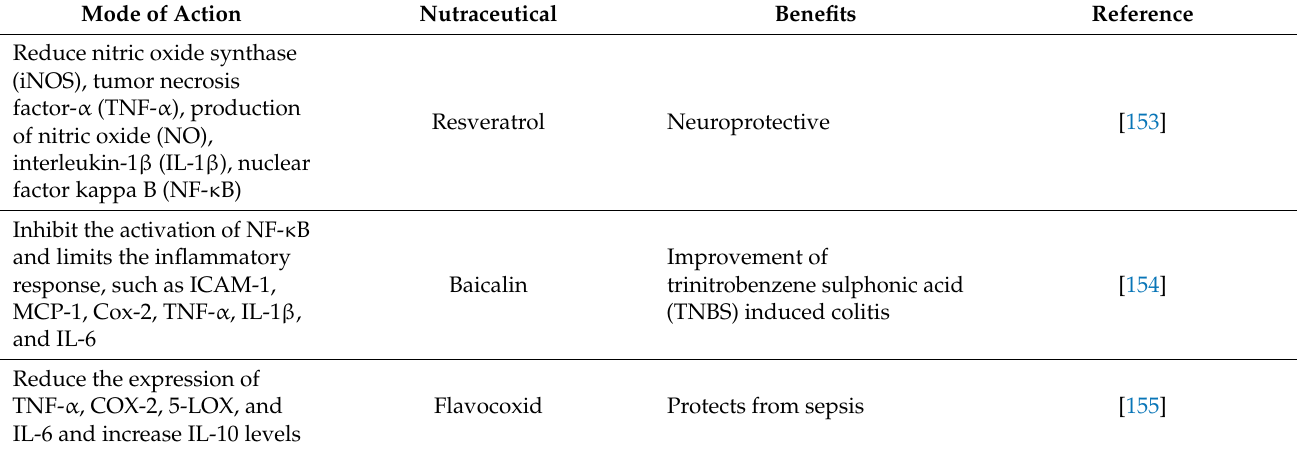
Table 3. Selected anti-inflammatory modes of action classified based on nutraceutical and benefits. Mode of